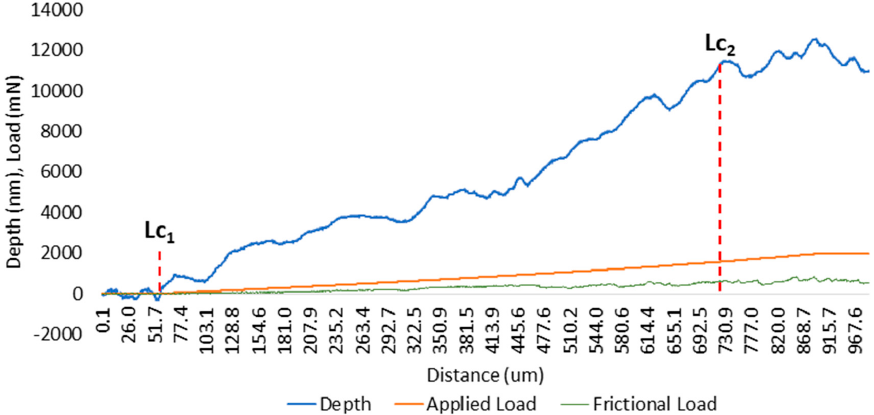
Figure 10. The scratch distance, indentation depth, applied load, and frictional load plot of the micro-scratch test.